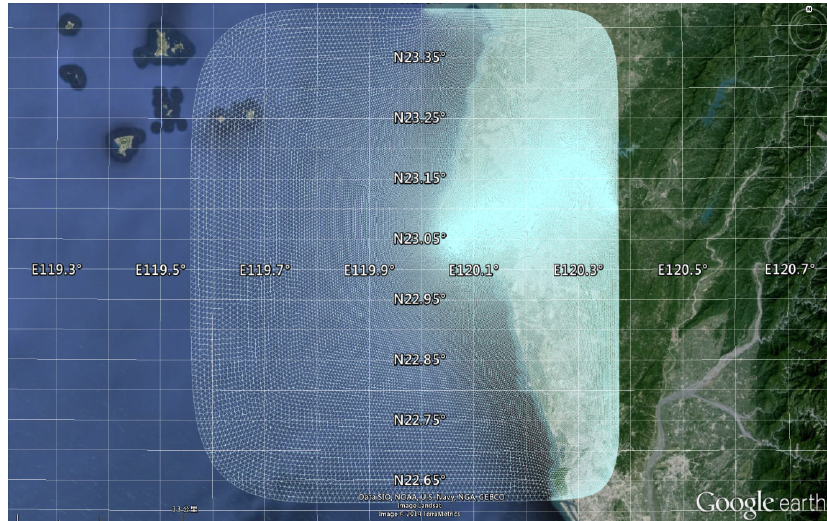
Figure 3. Unstructured grids for entire modeling domain including the Taiwan Strait,